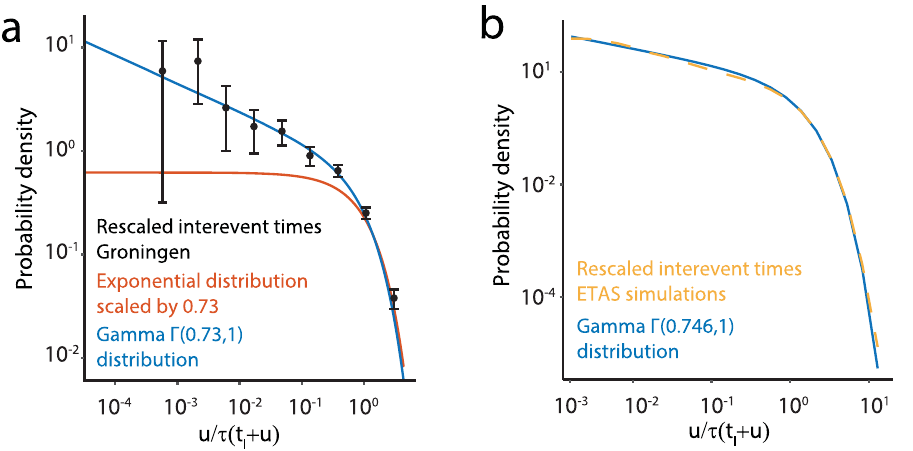
Figure 4. Gamma IAFT model compared to other models. ( a ) Estimated probability-density function (pdf) for the time-scaled interevent times, u / ˆ τ( t l + u ) , using a logarithmic binning of the 396 interevent times (black dots). For each estimate of the pdf a 95% confidence interval is presented, for details see Supplemental text S3. Furthermore, the Ŵ( ˆ k , 1 ) pdf (blue) and the Exponential ( k = 1 , red) pdf scaled by ˆ k are presented. ( b ) Distribution of interevent times from 500 Groningen-based synthetic ETAS catalogs, with a mean aftershock fraction equal to 0.766, scaled by the background rate at the time of events, u /τ( t l + u ) (dashed orange). A Gamma IAFT-model fit to all simulated interevent times follows the same distribution